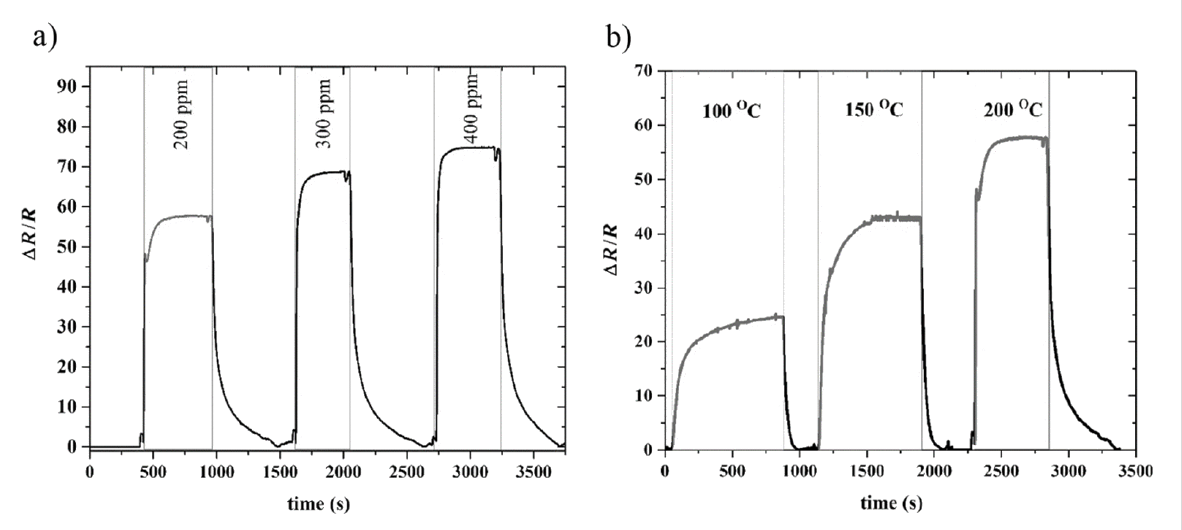
Figure 4: Typical response of MoS 2 nanoflakes toward methanol for: (a) different concentrations at 200 °C working temperature, (b) for 200 ppm at different working temperatures.